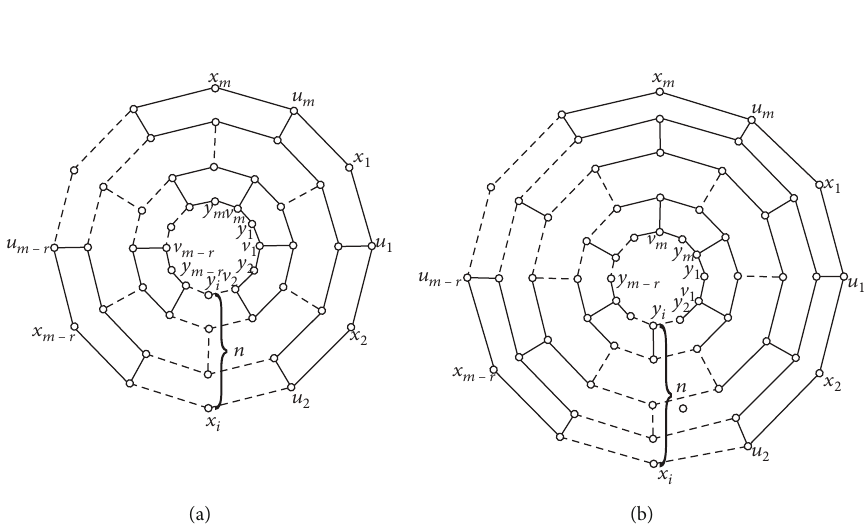
Figure 2: Plane spanning subgraphs of H